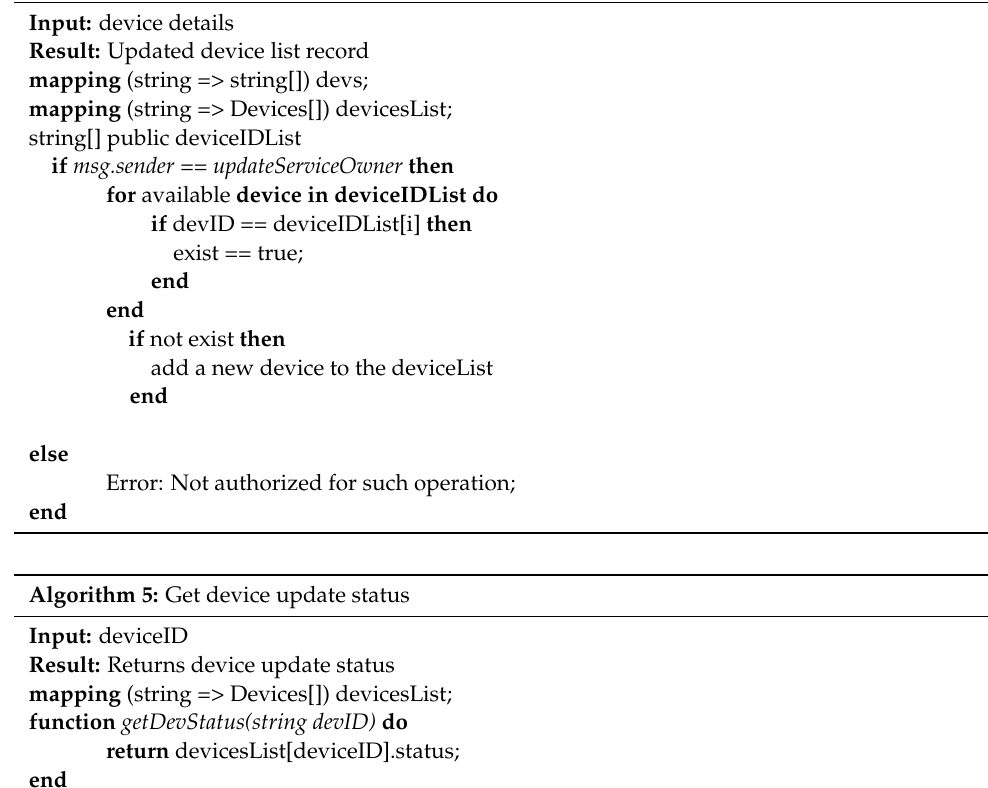
Algorithm 4 : Register a new LoRa device